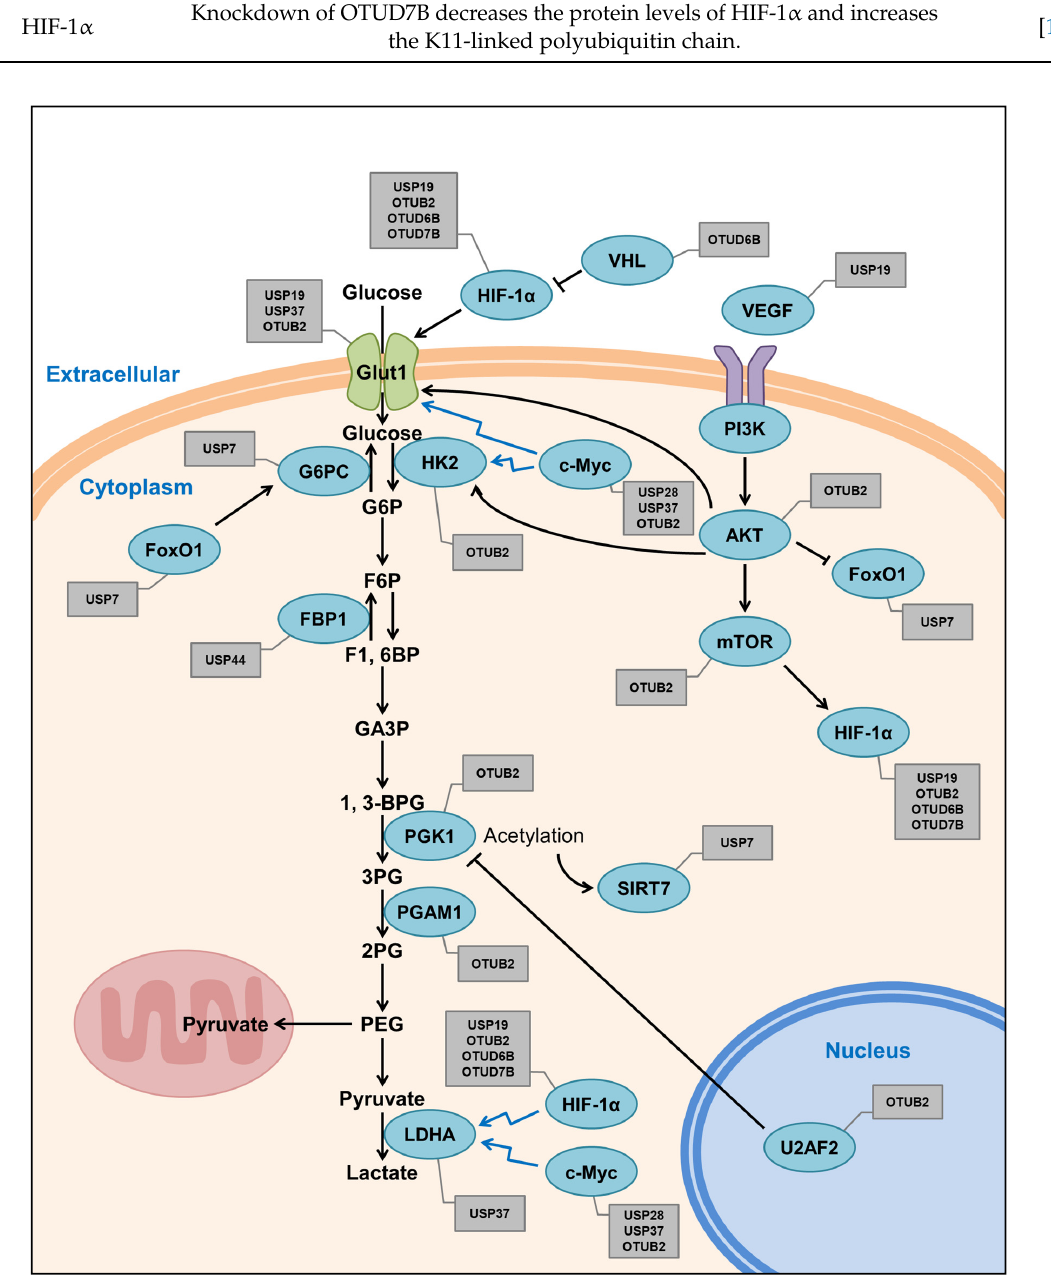
Figure 3. The schematic model for the Warburg effect modulated by DUBs and their substrates. The black arrow indicates direct stimulatory/inhibitory modification, and the blue arrow indicates transcriptional stimulatory modification. The blue circles represent the factors of the Warburg effect, and the gray square boxes represent their DUBs.